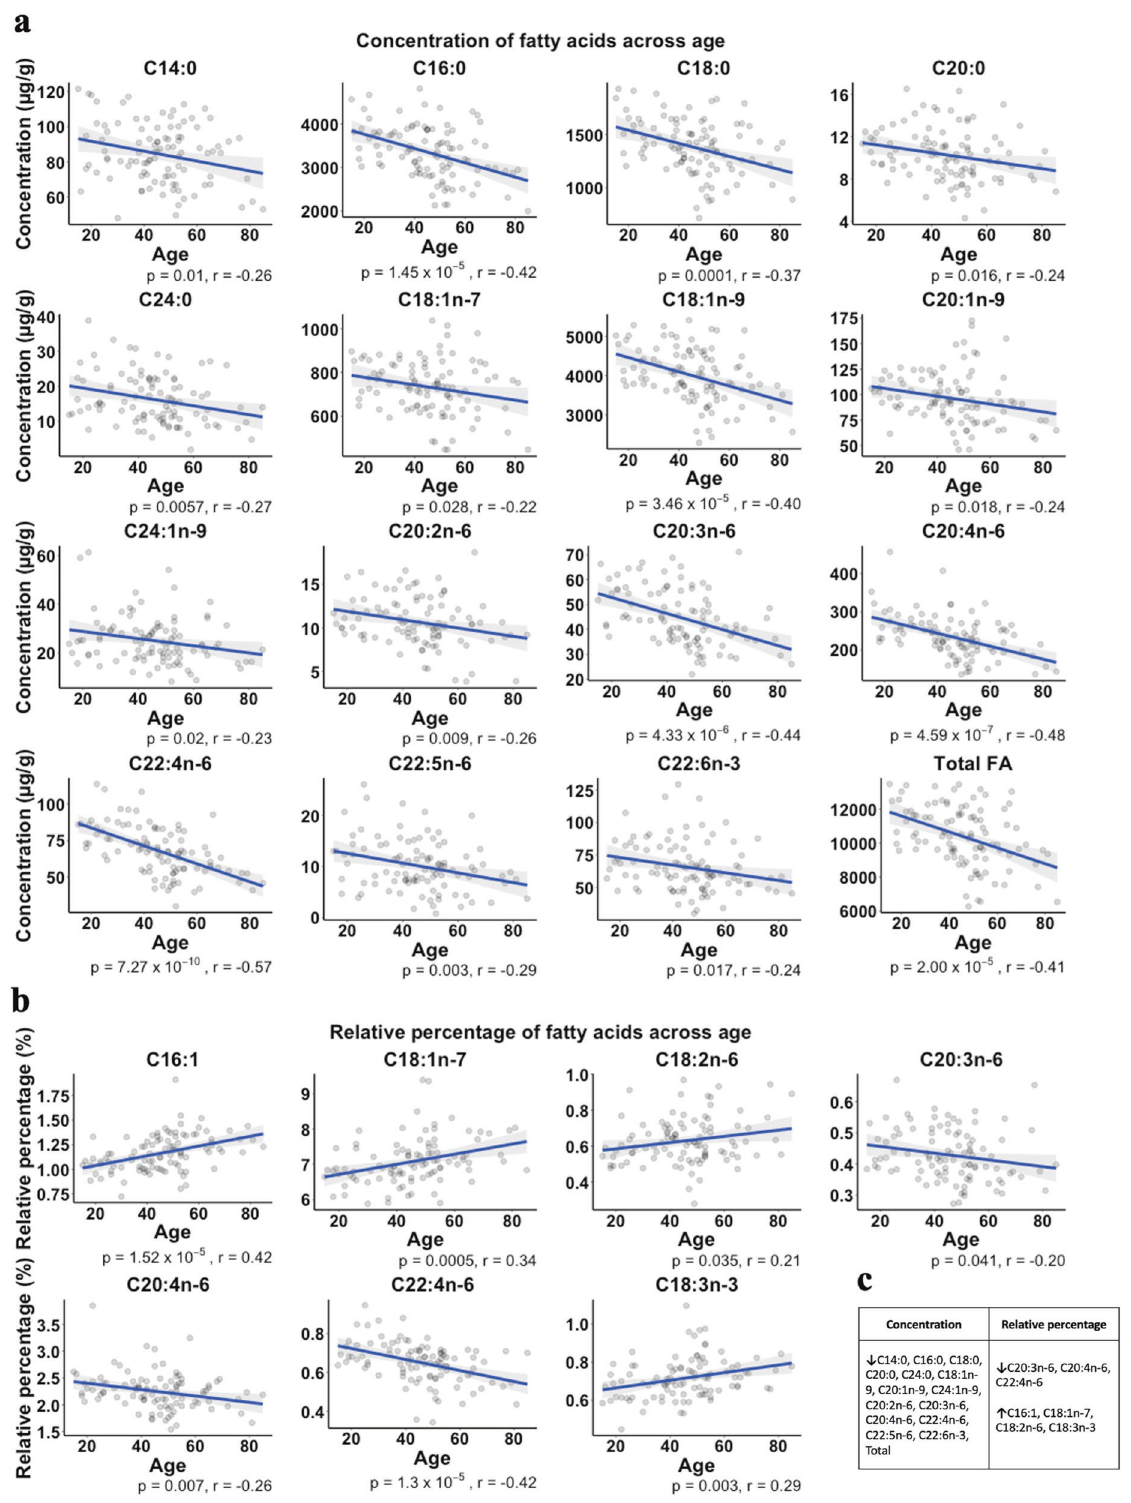
Fig. 4 Signi fi cant correlations between age and fatty acid quantitative metrics. Signi fi cant Pearson correlations between ( a ) age (years) and concentrations (µg/g) of FAs and ( b ) age (yrs) and relative percentage. P -values and r -values are listed under each subplot. A summary table of these signi fi cant correlations is presented in ( c ) in which a negative correlation is represented by a downward arrow and a positive correlation is represented by an upward